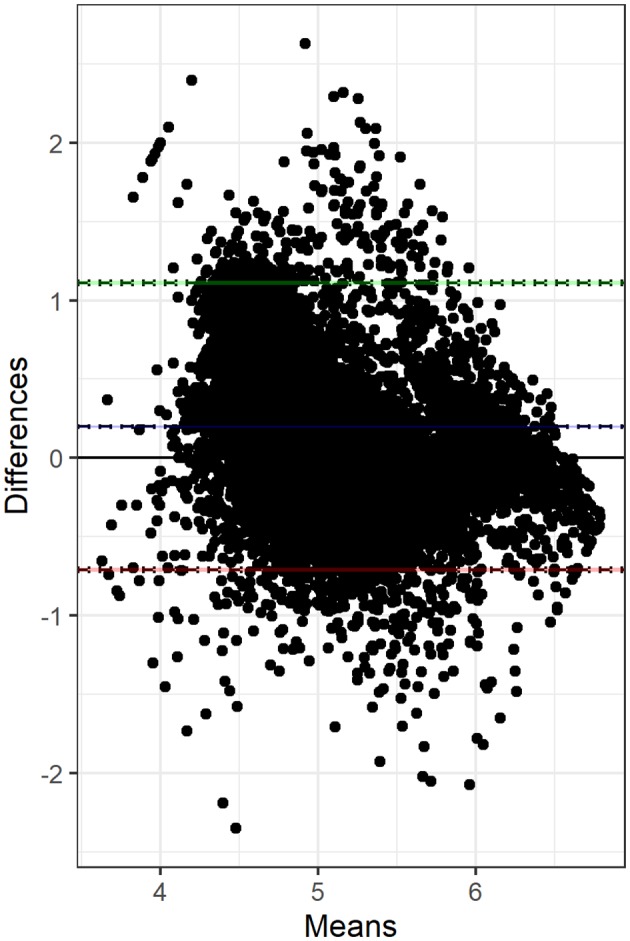
Bland-Altman plot displays the difference between single log10-transformed online CMT (O-CMT) values and log10-transformed laboratory measured SCC (L-SCC) against the average of both measurements on the DHI test days. Most of the records are within the limits of agreement. Overall, the differences between the two measurements are decreasing.